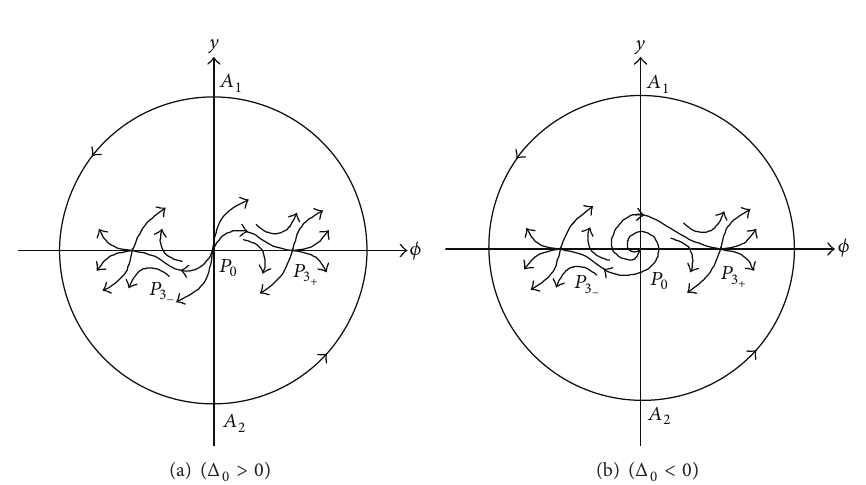
Figure 3: ( 𝛽 > 0 , 𝑎 < 0 , 𝑏 > 0 , 𝑐 < 0 , Δ > 0 ).